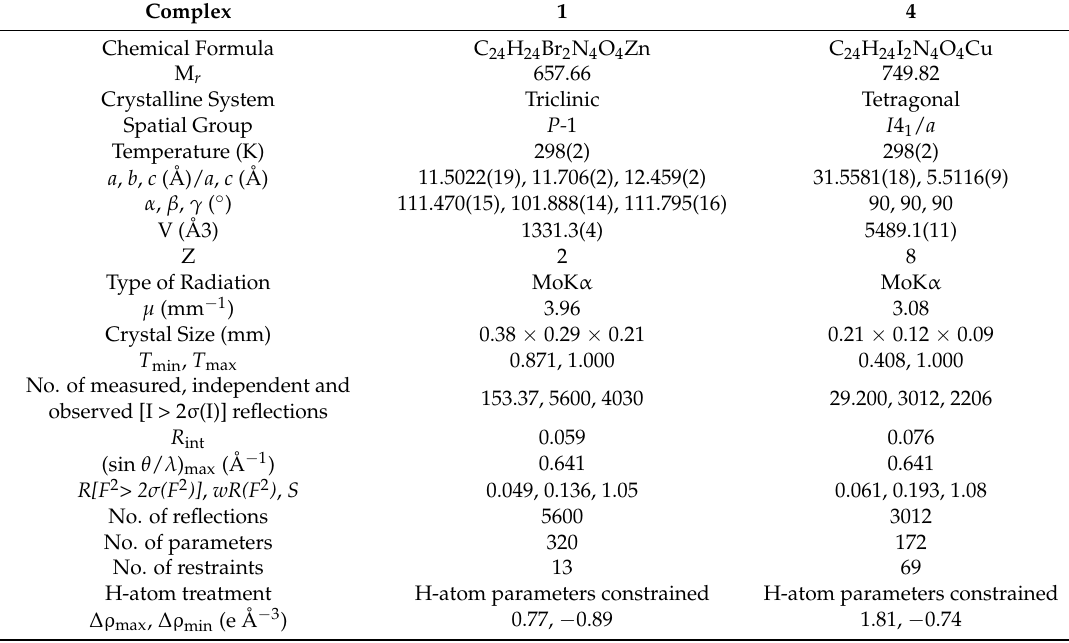
Table 3. Crystallographic data and experimental details for complexes 1 and 4 .